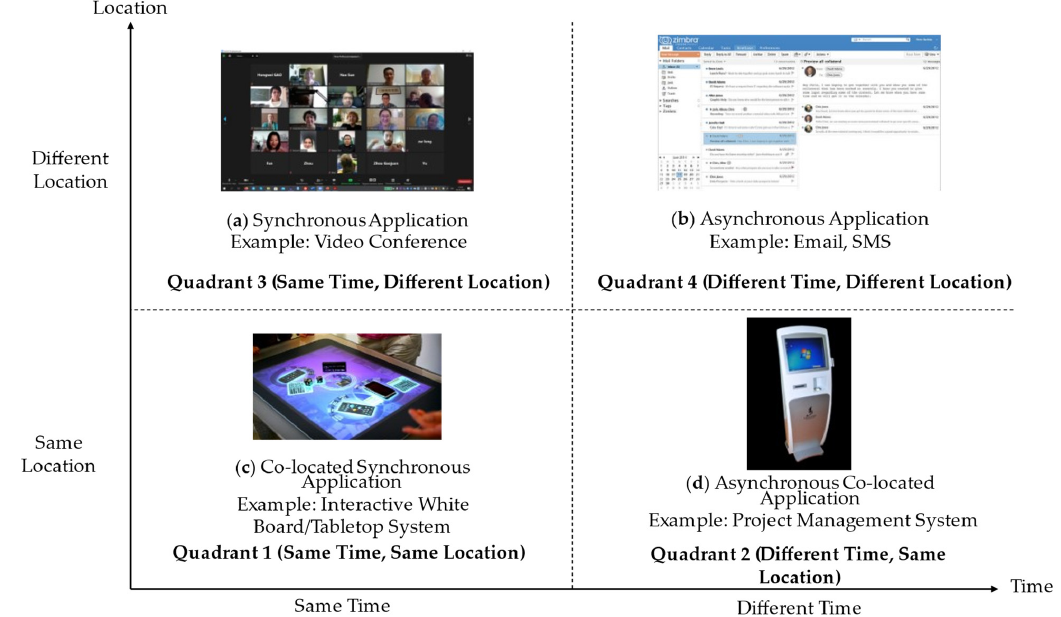
Figure 1. The time space matrix for CSCW: ( a ) The interface of Video Conferences for different location same time Tabletop System matrix [10]; ( b ) Example of different location and time using email application [11]. ( c ) Tabletop System for same location and time matrix [12]; ( d ) Kiosk System for same location different time matrix [13].